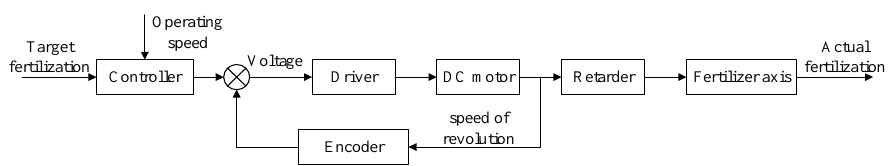
Figure 5. Variable-rate fertilization system in an orchard control block diagram.